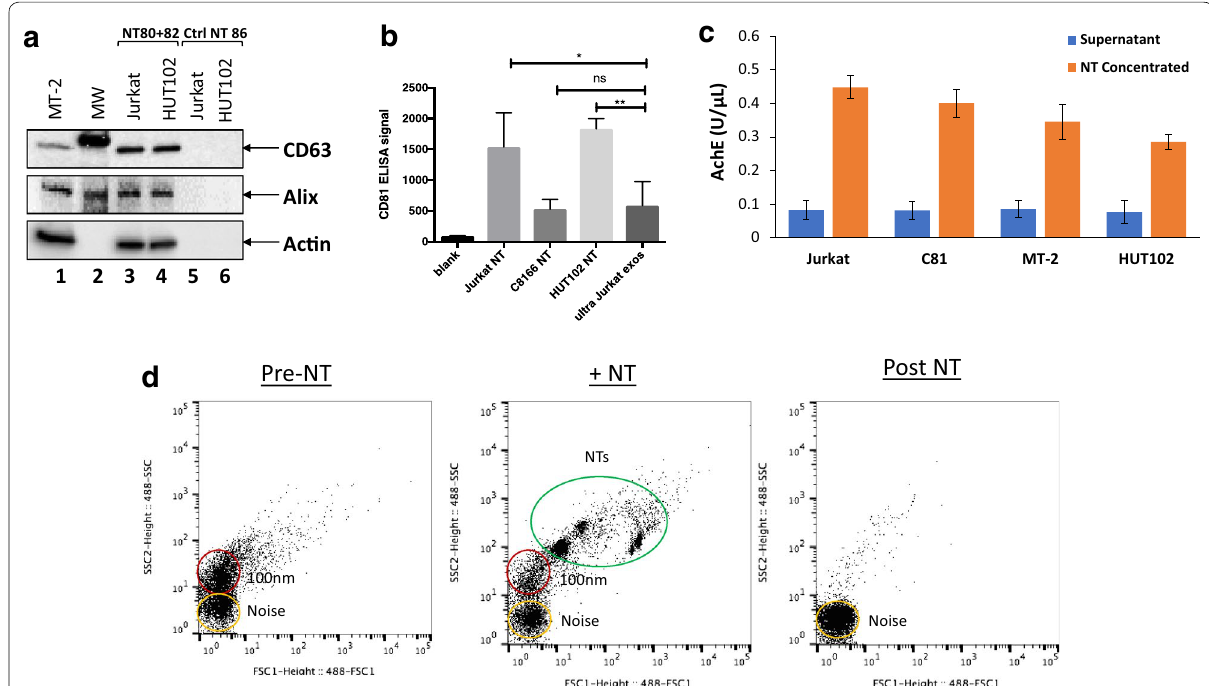
Fig. 1 Nanotrapping exosomes from tissue culture supernatants. a CD63, Alix, and Actin levels from exosomes nanotrapped by either NT80 particles (lanes 3 and 4) or by NT86 particles (Ctrl NT 86; lanes 5 and 6) from Jurkat (HTLV‑1 uninfected) and HUT102 (HTLV‑1 infected) tissue culture supernatants were analyzed by Western blot. MT‑2 whole cell extracts and molecular weight (MW) ladder are shown (lanes 1 and 2). b CD81 ELISA signals were measured from isolated exosomes as a measure of exosome concentration. Exosomes were nanotrapped (designated by NT) from HTLV‑1 negative Jurkat, and HTLV‑1 infected C8166 and HUT102 cells from 1 mL of starting tissue culture supernatant. The